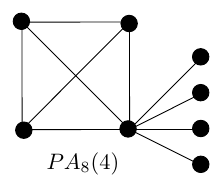
Figure 3. A pineapple